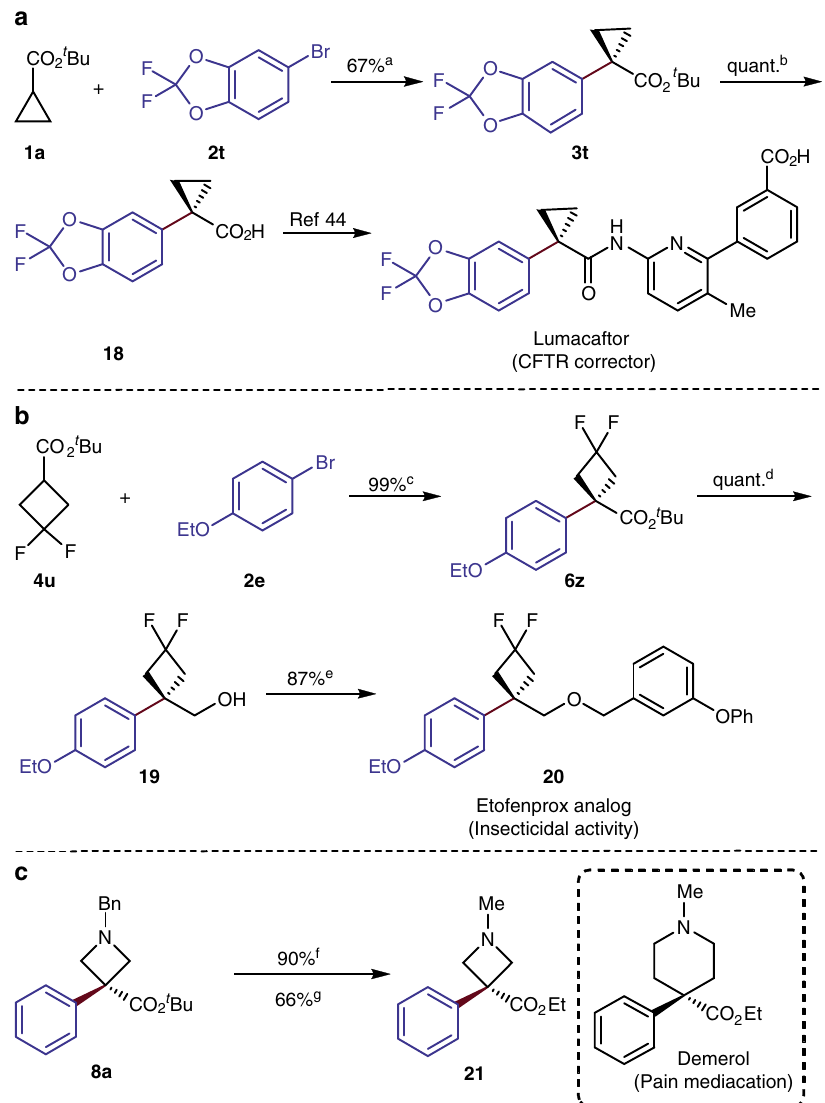
Fig. 6 Applications to biologically relevant molecules. a Synthesis of Lumacaftor. b Synthesis of Etofenprox analog. c Synthesis of Demerol analog. a Standard condition as shown in Fig. 2 without using AgBF d LiAlH ° C – RT. e NaH, 1-(bromomethyl)-3-phenoxybenzene, THF, 0 ° C – RT. f Step 1: HCl·dioxane, RT. Step 2: (COCl) 4 , Et 2 O, 0 g Pd/C, H 2 , CH 3 OH, RT. quant.: